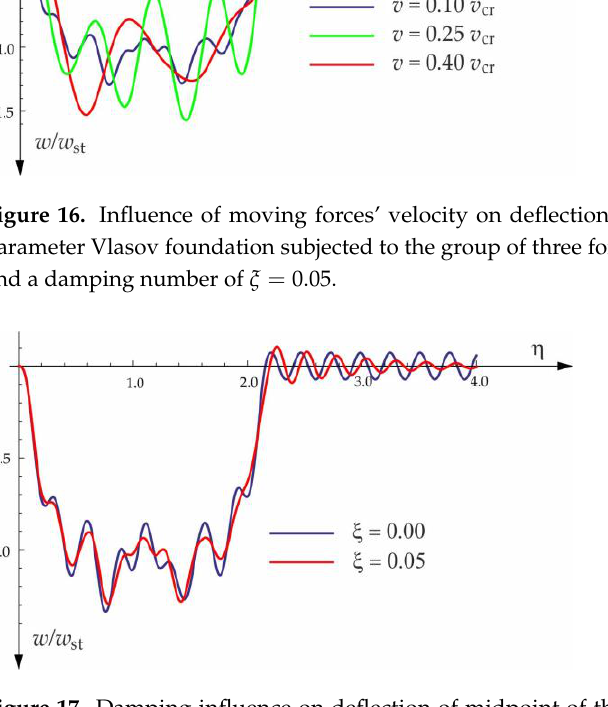
( b ) Figure 18. Influence of foundation parameters on the deflection of the midpoint of the beam sub- jected to the group of three forces moving at a velocity of 50 m s v = and a distance of 3 m a = : ( a ) mass coefficient, ( b ) shear coefficient. 5. Conclusions The problem of a beam on a three-parameter inertial foundation under a moving load was discussed in the paper and can be used as a benchmark in the calculation of structures under moving loads caused by road or railroad vehicles. In most cases, in an- alytical solutions, the authors discuss loading with a single force, a material point, or an oscillator. The solutions presented in this paper helps to assess the influence of the group of moving forces and their distance on the displacement of the beam on the Vlasov foundation. Based on the conducted analysis, it can be seen that the appropriate selection